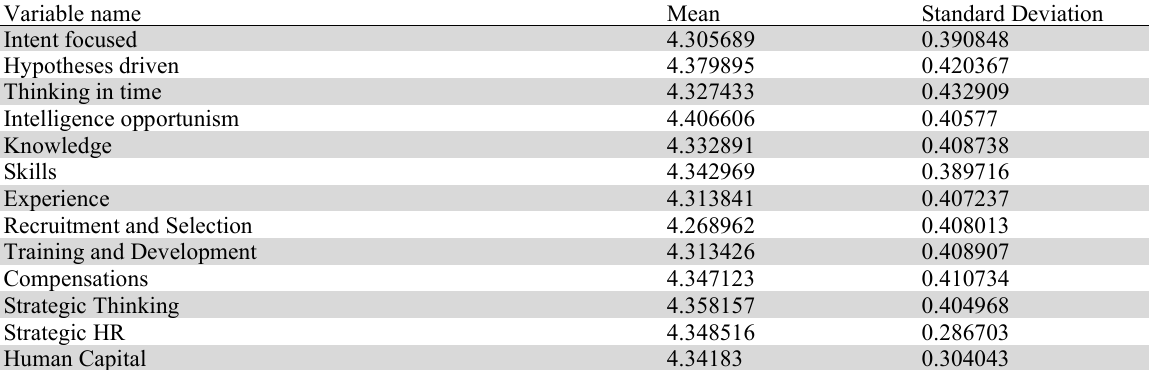
Descriptive statistics of the